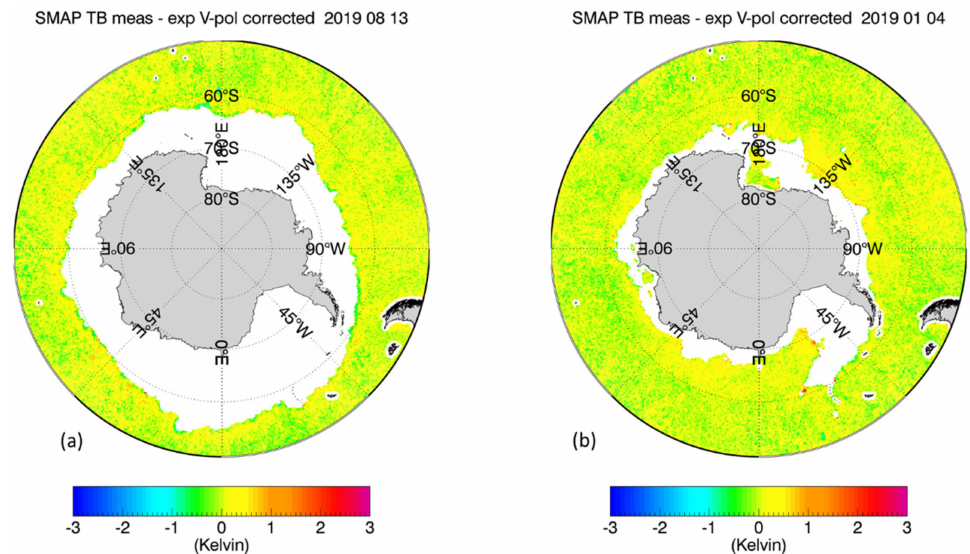
Figure 9. SMAP V-pol TB biases for the test cases from Figures 1 and 2 after flagging and sea-ice correction within sea-ice Zones 0–2. ( a ) 13 August 2019; ( b ) 4 January 2019.